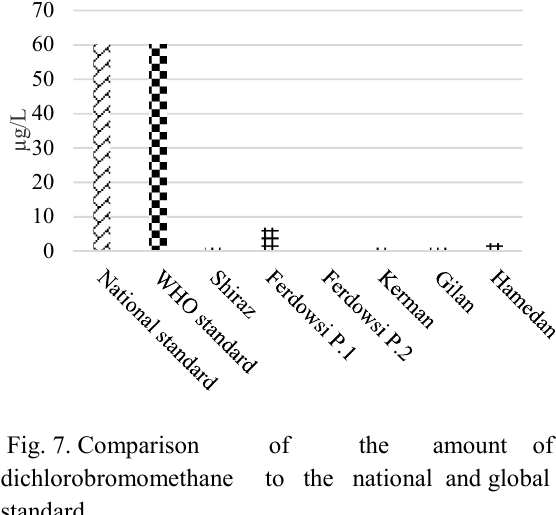
Fig. 7. Comparison of the amount of dichlorobromomethane to the national and global standard